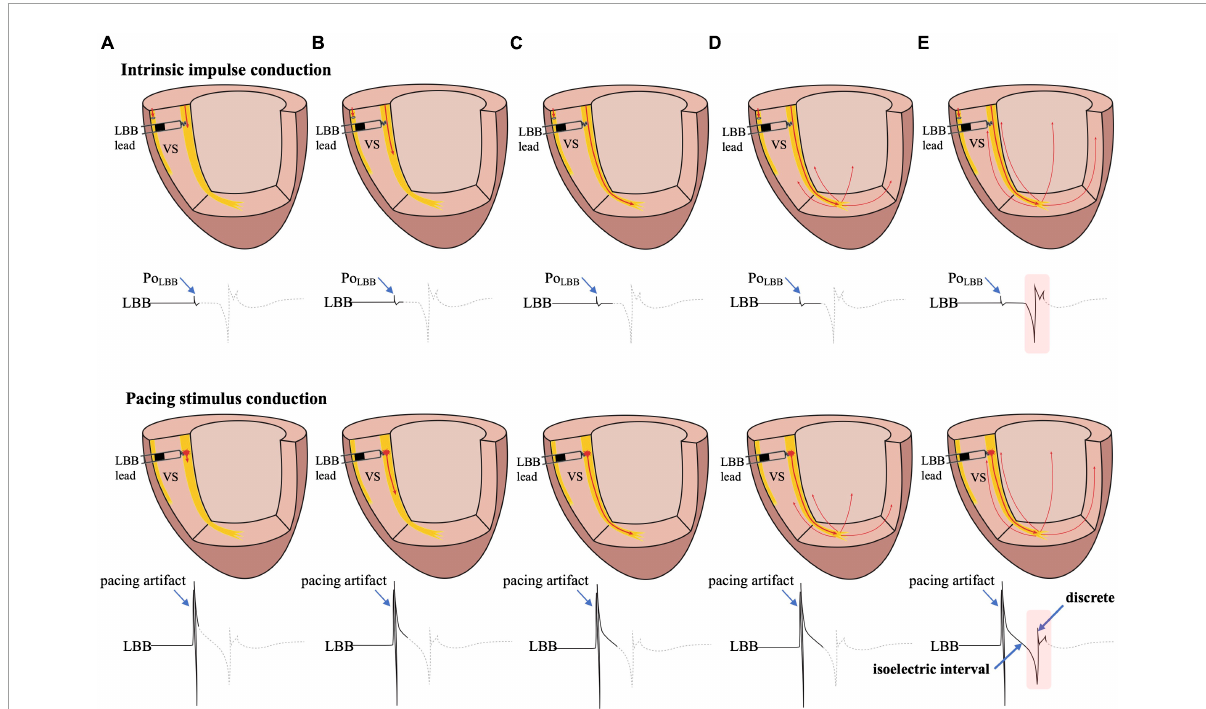
FIGURE2 The possible mechanism of the formation of the isoelectric interval and discrete electrogram. (A) Intrinsic impulse or pacing stimulus in the LBB is sensed by the tip lead. (B–D) The formation process of the isoelectric interval. (E) Intrinsic impulse or pacing stimulus reaches the distal end of the His-Purkinje system, excites the apical myocardium, propagates into the basal myocardium, and is then sensed by the tip lead, manifesting as an isoelectric interval and discrete electrogram. Abbreviations as in Figure 1